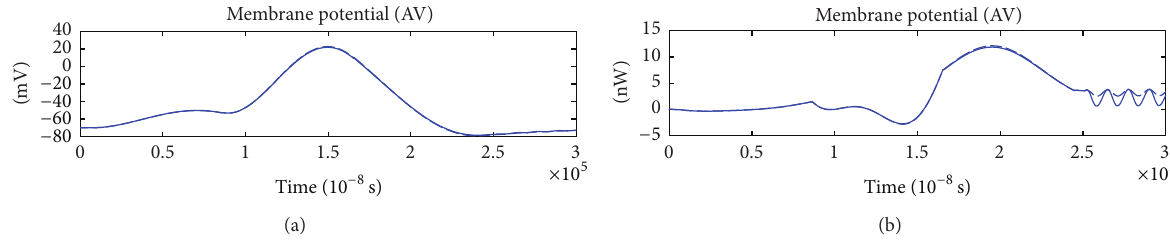
Figure 10: The action potential and its corresponding function. 𝑟 0𝑚 = 0.0001 Ω , 𝑟 1𝑚 = 0.1 Ω , 𝑟 2𝑚 = 1000 Ω , 𝑟 3𝑚 = 0.1 Ω , 𝑟 𝑚 = 1000 Ω , = 1 𝜇 F, 𝐿 = 50 𝜇 H, 𝑖 = 70.7 𝜇 A, and 𝑄 = 6 × 10 −6 𝜇 A. 𝐶 𝑚 𝑚 0𝑚